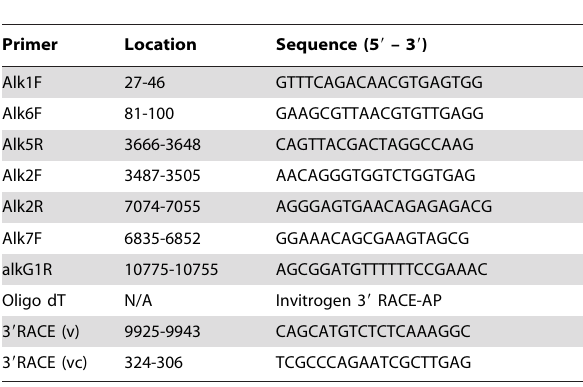
Table 2. Primers used for amplification of AHFV and